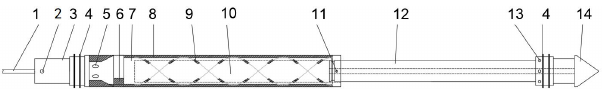
Figure 3. Schematic diagram of the main structure: sensing optical fiber (1), locating pin (2), mounting rod (3), block circle (4), thread- ing hole (5), conductor groove (6), tube body (7), epoxy resin (8), FBG sensor group (9), glue capsule (10), pin hole (11), piston rod (12), rubber outlet hole (13), conical guider (14).